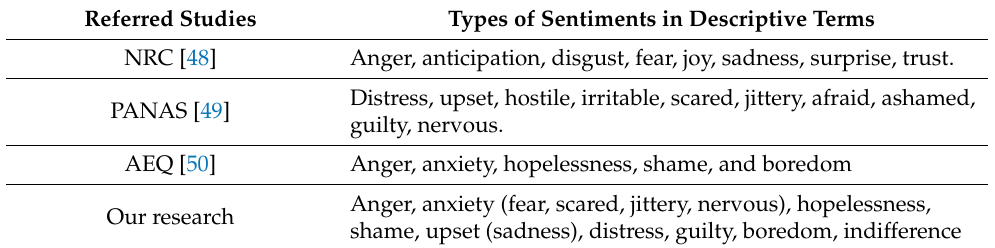
Table 1. Sentiment categories in descriptive terms.